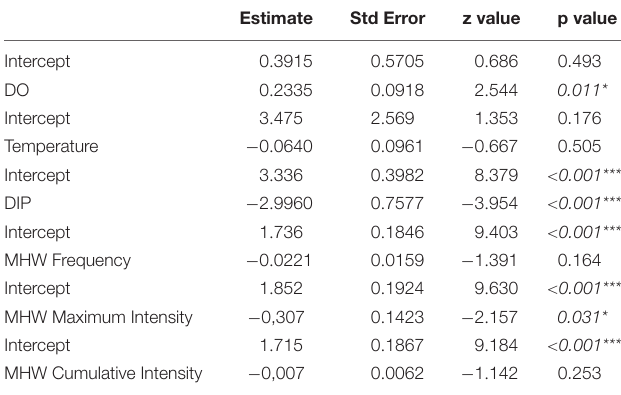
TABLE 1 | GLM results for the Bay of Santa Catarina Island between 2001 and